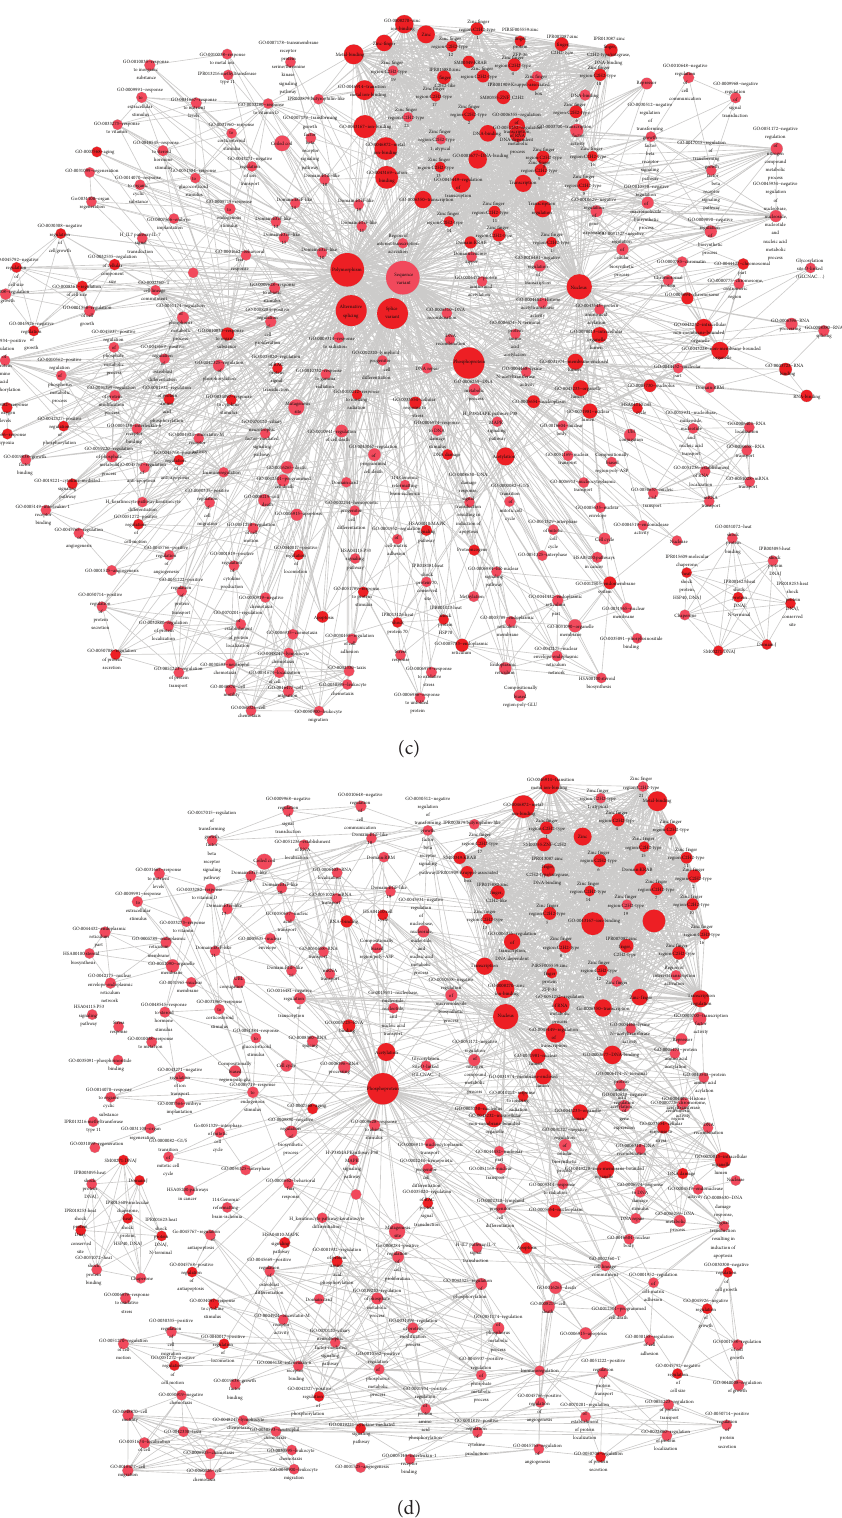
Figure 3: Visualization of Functional Annotation Chart analysis for DEGs and their comparison. (a) Visualization of Functional Annotation Chart analysis of LOXL2-e13-DEGs. (b) Visualization of Functional Annotation Chart analysis of LOXL2-WT-DEGs. (c) The unique Functional Annotation Chart of LOXL2-e13-DEGs. (d) The unique Functional Annotation Chart of